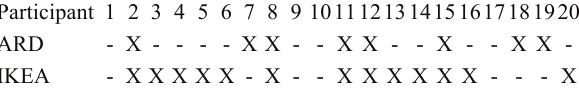
Table 1. Participants with occurrence of one or more T-patterns meeting the minimum scanpath